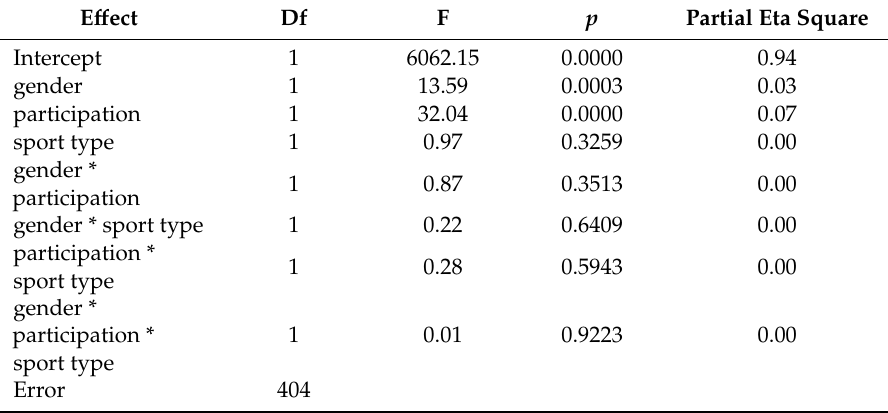
Table 5. Three-way ANOVA summary for the POSQ ego subscale.